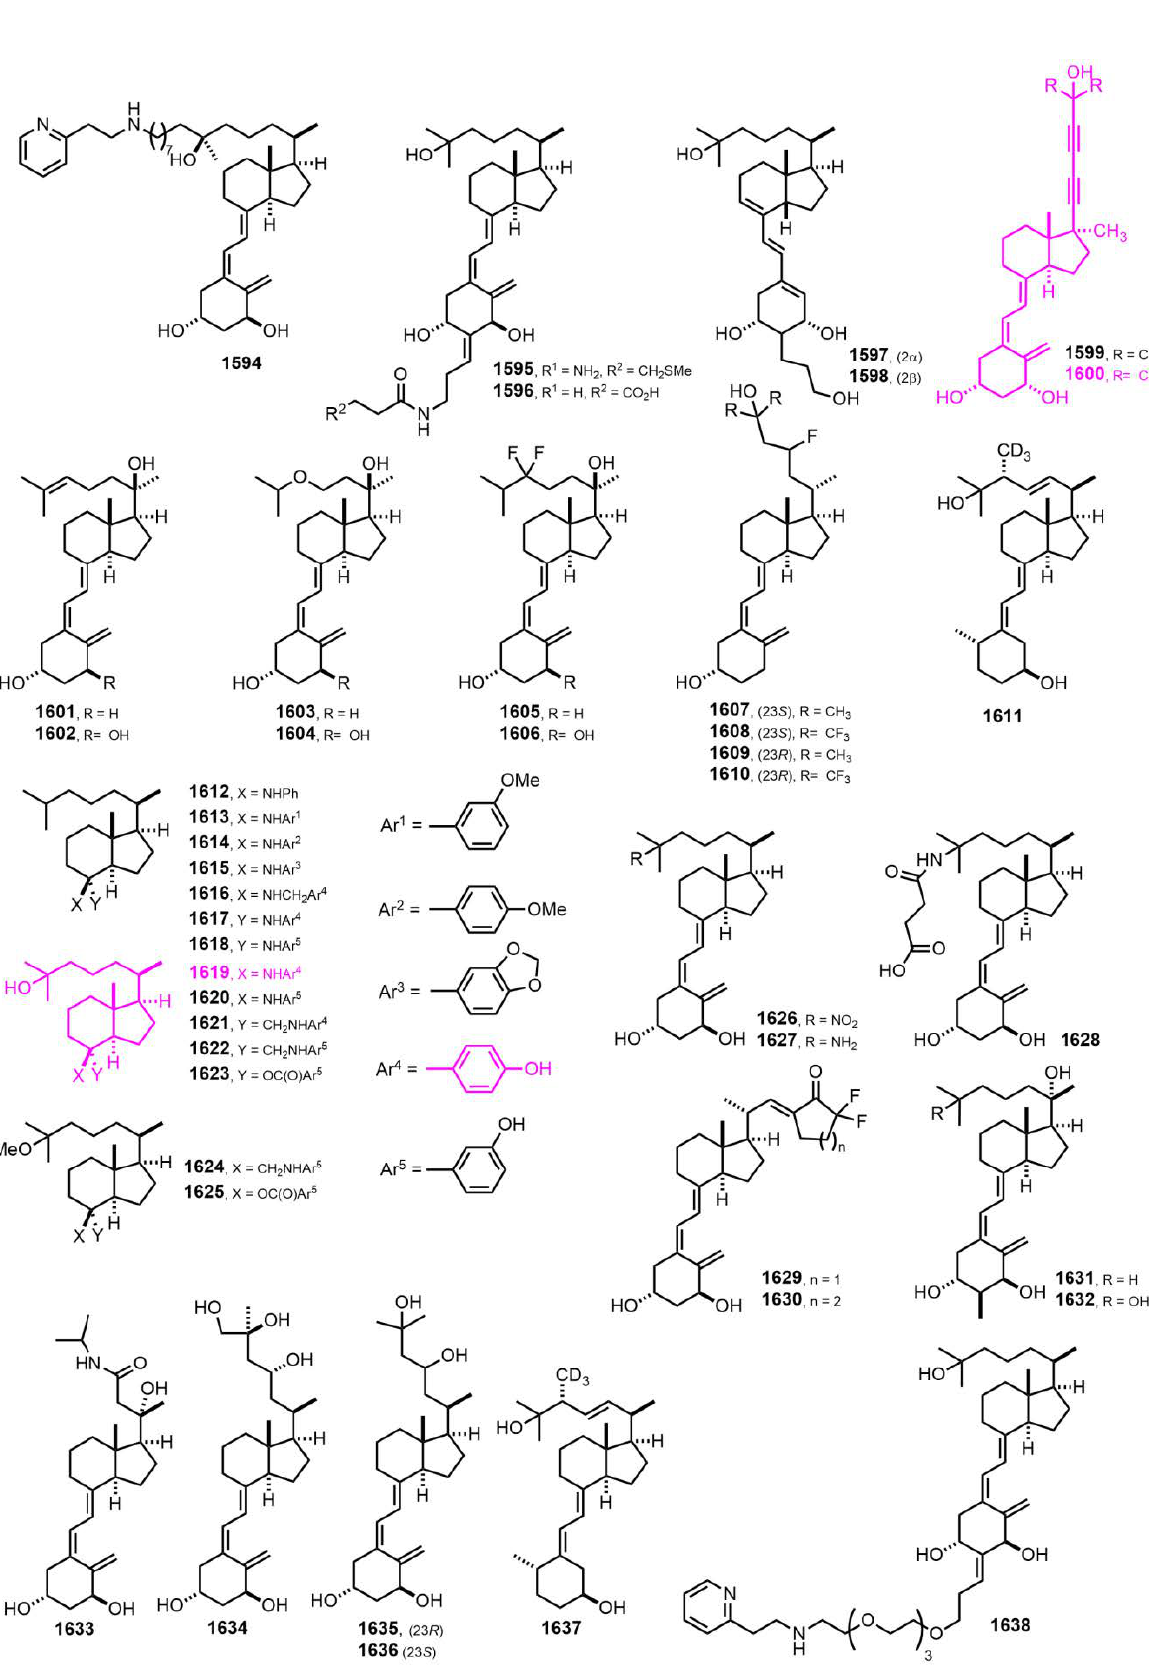
Figure 28. (2018–2019)